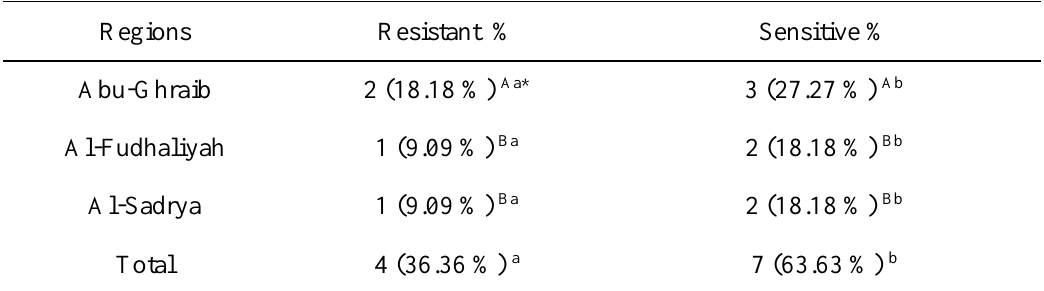
Table 4. Antibiotics sensitivity profile of A. hydrophila isolates